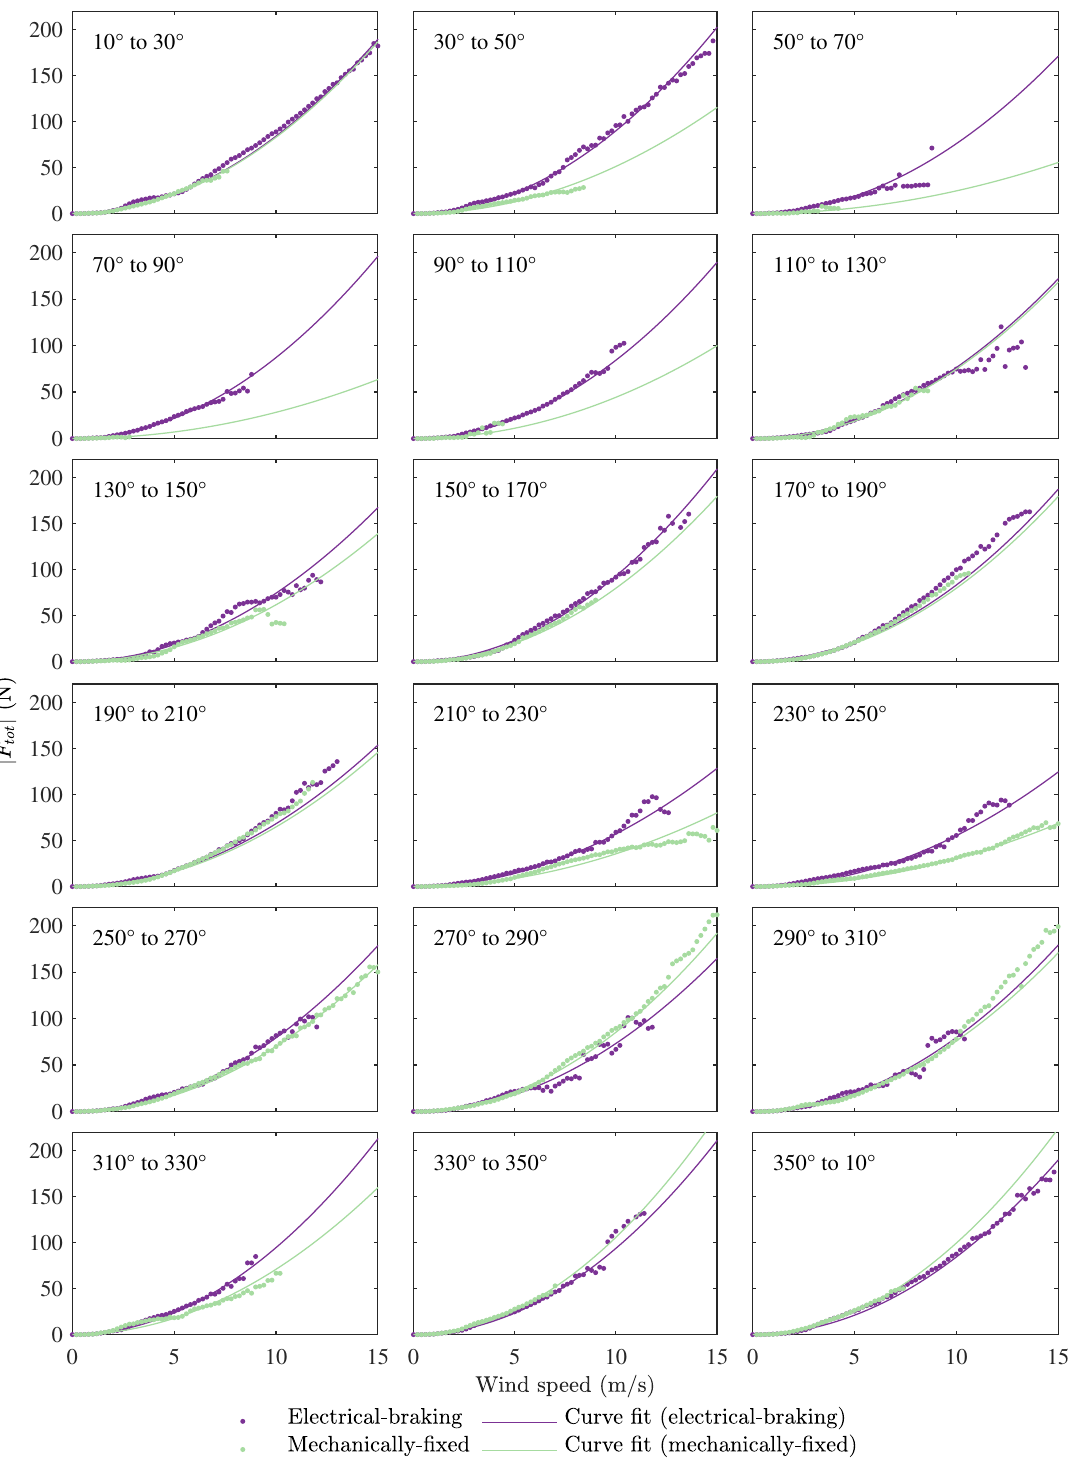
Figure 5. The total force on the blade sorted by wind direction. In each direction the data have been grouped by the wind speed, and the average of each wind speed is plotted. The presented curve-fits are based on all data in each